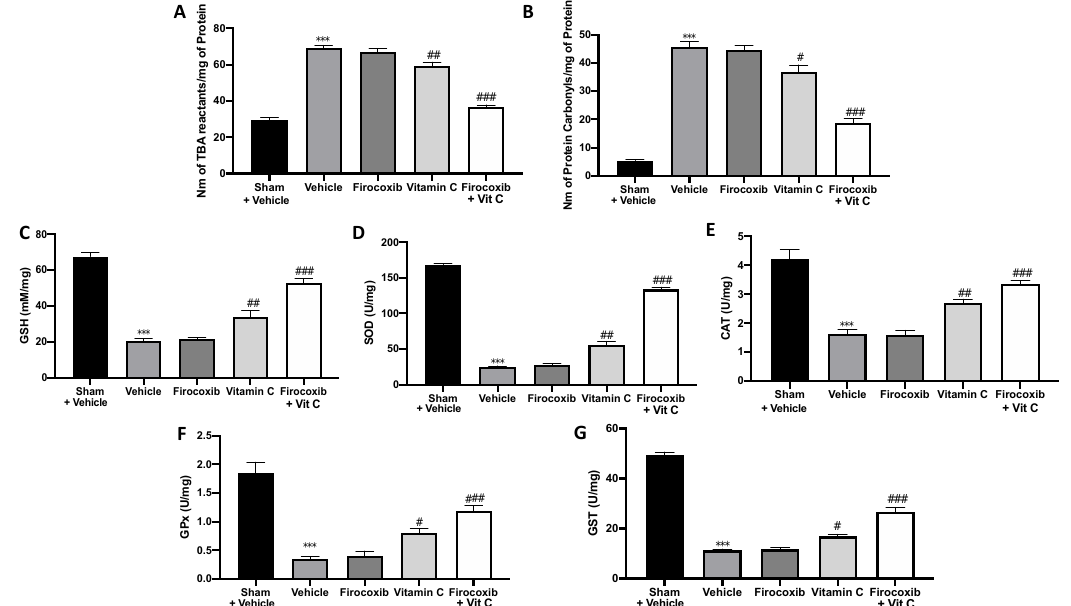
Figure 3. Effect of combined firocoxib and vitamin C therapy on oxidative stress: ( A ) Lipid peroxidation, ( B ) protein carbonyl, ( C ) total glutathione (GSH), ( D ) superoxide dismutase (SOD), ( E ) catalase (CAT), ( F ) glutathione peroxidase (GPx), and ( G ) glutathione-S-transferase (GST). n = 5 animals from each group for each analysis. A p -value of <0.05 was considered significant; # p < 0.05 vs. vehicle, ## p < 0.01 vs. vehicle, *** p < 0.001 vs. sham + vehicle, and ### p < 0.001 vs. vehicle.